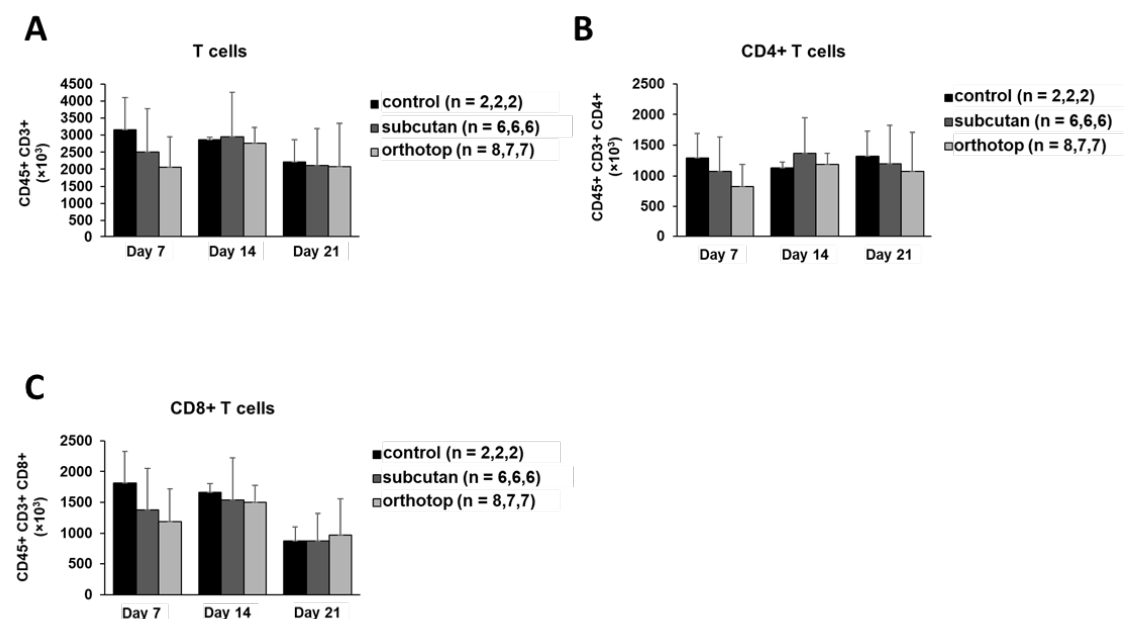
Figure 9. Cellular composition in the thymus of orthotopic and subcutaneous HNSCC-bearing mice. ( A – C ) Populations of T cells were analyzed using flow cytometry 7 days, 14 days, and 21 days after tumor induction. On day 7, day 14, and day 21 the test group size for the subcutaneous group is n = 6, while for the control group n = 2. The test group size for the orthotopic group on day 7 is n = 8, day 14 n = 7, and day 21 n = 7. p -values < 0.05 were considered to be significant with (*). Data shown here are listed in Table S6.